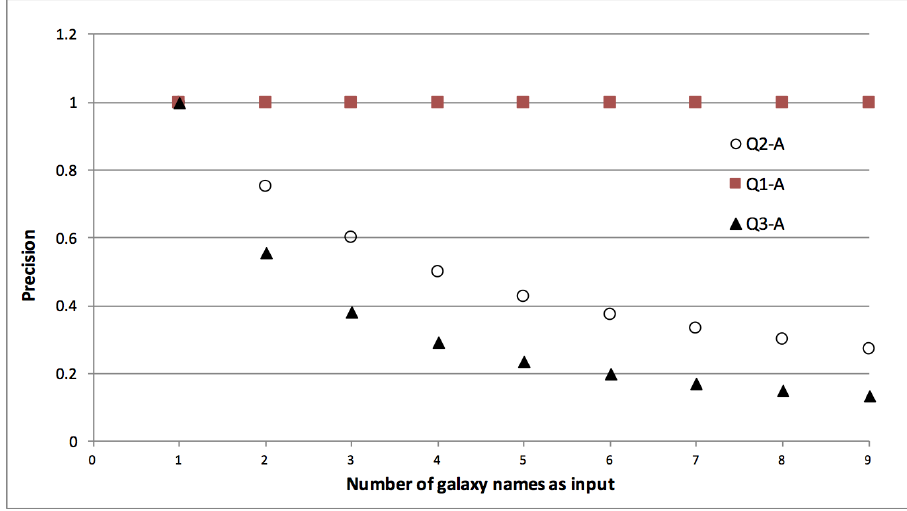
Figure 16. Precision of results when queries are run over annotated (labelled)